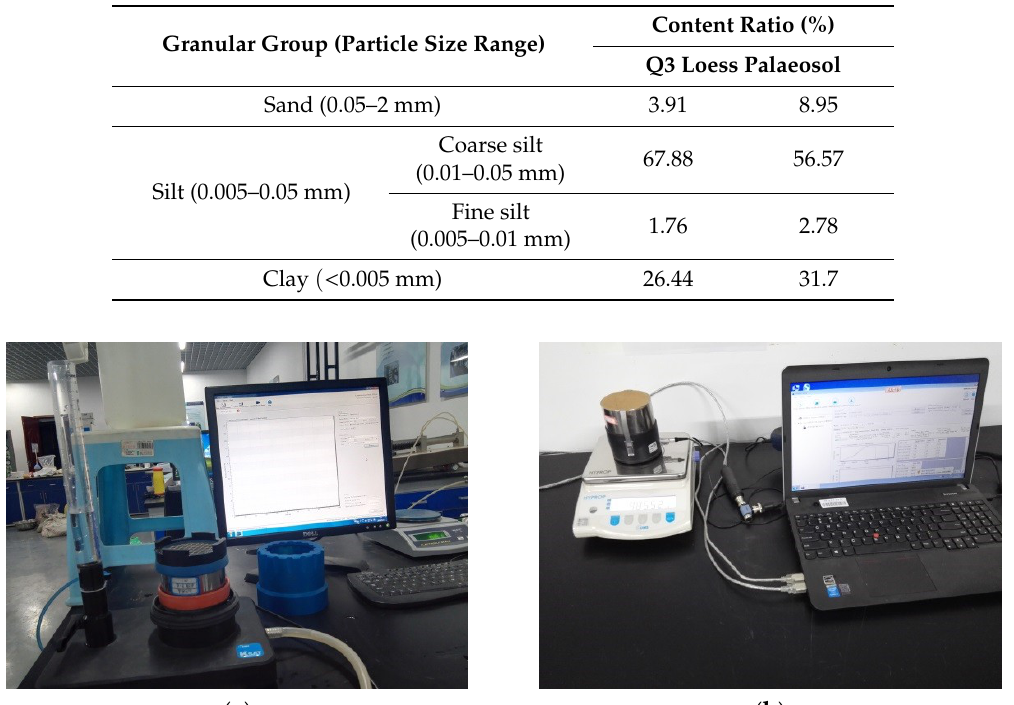
Figure 5. The devices for the basic hydraulic properties: ( a ) the Ksat device; ( b ) the HYPROP device. Table 1. Grain size distribution.